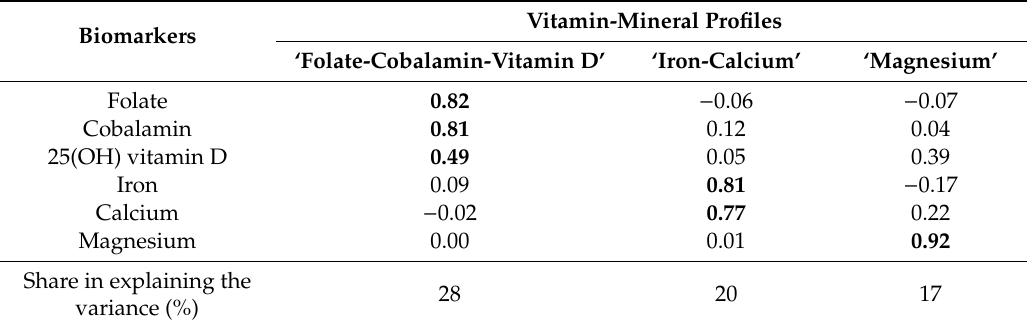
Table 2. Factor loadings for serum vitamins and mineral concentrations in Principal Component Analysis (PCA)-derived profiles among postmenopausal women ( n =